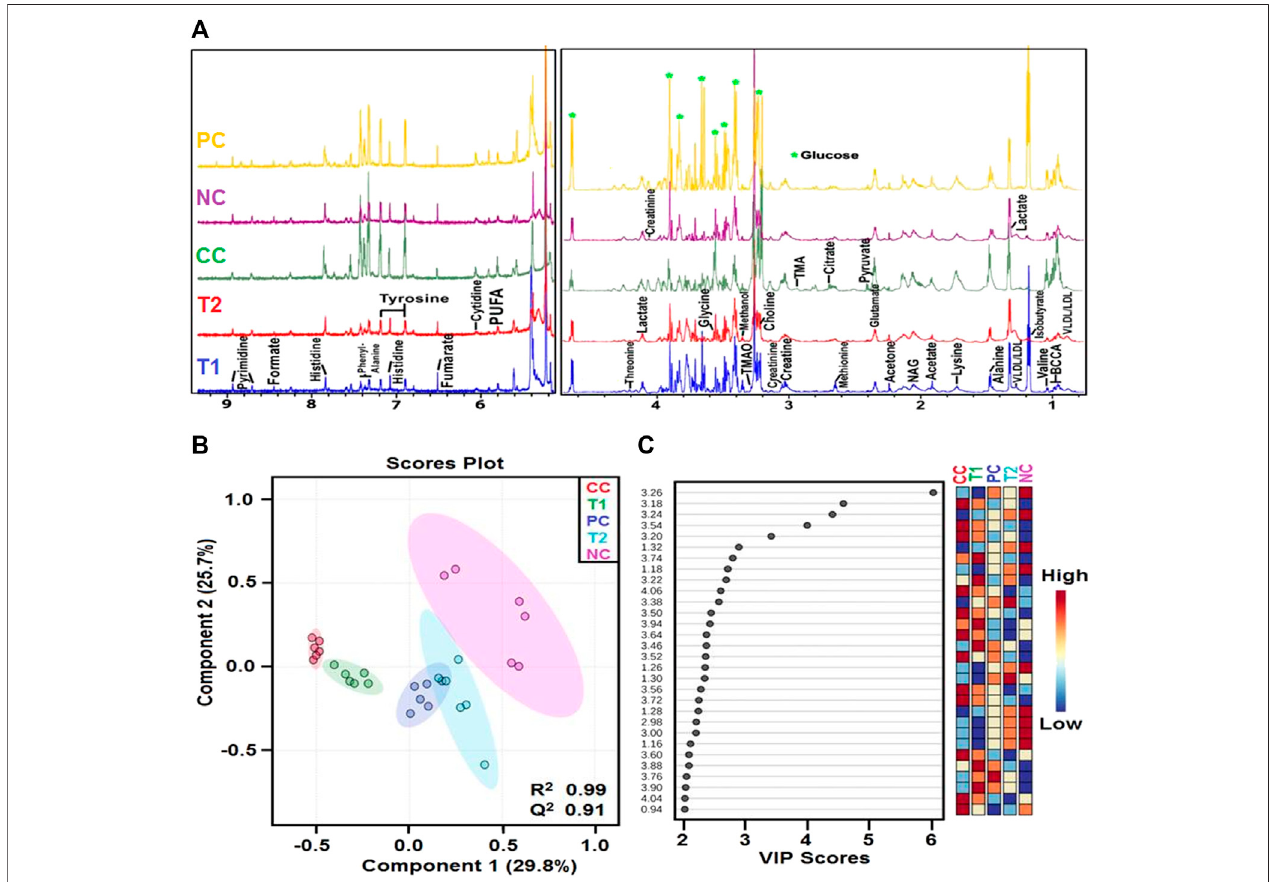
FIGURE 5 | (A) Stack plot of representative ID H CPMG NMR spectra of rat serum obtained from different groups NC, Normal Control; CC, Carcinogen Control; PC, Positive Control; TI, DI (100 mg kg) and 12, DI (200 mg kg) and (B) OPLS-DA analysis: The 2D OPLS-DA analysis of ID H CPMG NMR spectra score plot derived fromcombinedanalysiscomprisingofallthegroups.NC,NormalControl;CC,CarcinogenControl;PC,PositiveControl;T1,DI(100 mg kg)andT2:DI(200 mg/kg). (C) The potential discriminatory metabolite entities identi fi ed from VIP scores derived from OPIS-DA modeling of complete data matrix and resulted VIP scores for top 30 metabolite entities are shown in increasing order of VIP score values to highlight their discriminatory